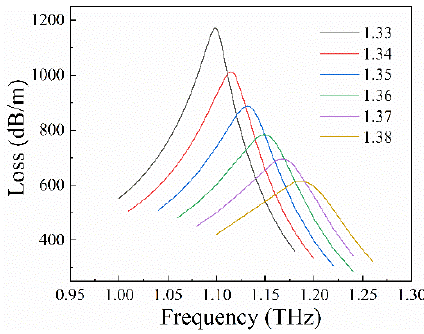
Figure 5. Loss peak curves with different RI of bioanalyte.